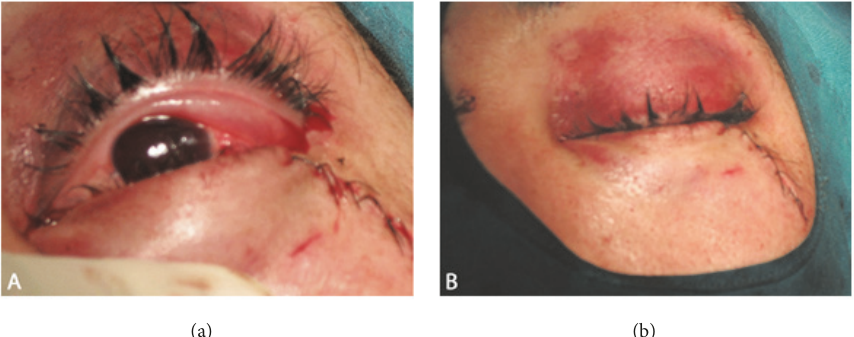
Figure 4: (a) and (b) Result in the immediate postoperative period is shown. The eyeball had a normal tone and the upper eyelid had a good aesthetic